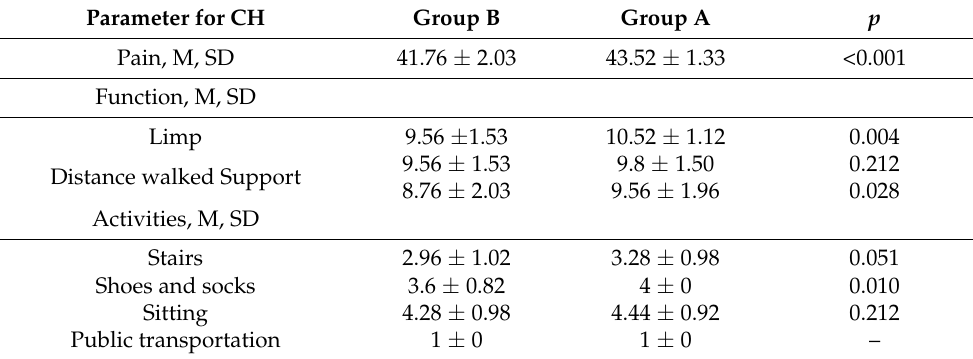
Table 6. The values of the mHHS parameters at the CH level, at the end of the study. Parameter for